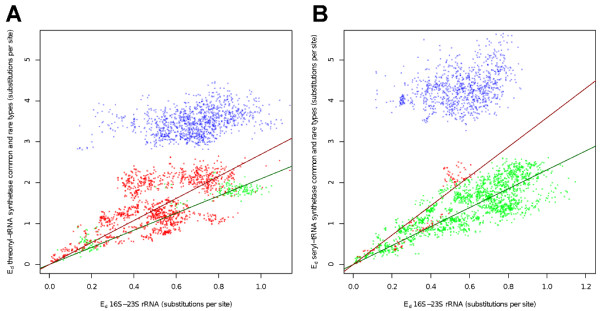
Scatterplots of pairwise evolutionary distances between the combined 16S-23S rRNA (x-axis) and (A) ThrRS and (B) SerRS sequences on y-axis from a diverse sampling of bacteria. In (A), distances between taxa within the ThrRS-R clade (plotted in red) show a strong correlation with the rRNA distances (R2 = 0.90, P < 2.2 × 10-16), as do the distances within the ThrRS-C plotted in green (R2 = 0.98, P < 2.2 × 10-16). Pairwise distances for Aeropyrum pernix and Ignicoccus hospitalis were not included in the scatterplot because of the high rate of sequence divergence (long branches in Figure 2B). A strong correlation between the pairwise distances is expected for two trees with similar topologies. In (B), the distances for each clade show a strong correlation with the rRNA distances. Distances with the SerRS-R are plotted in red (R2 = 0.94, P < 2.2 × 10-16) and SerRS-C in green (R2 = 0.95, P < 2.2 × 10-16). Pairwise distances between each clade are shown in blue.